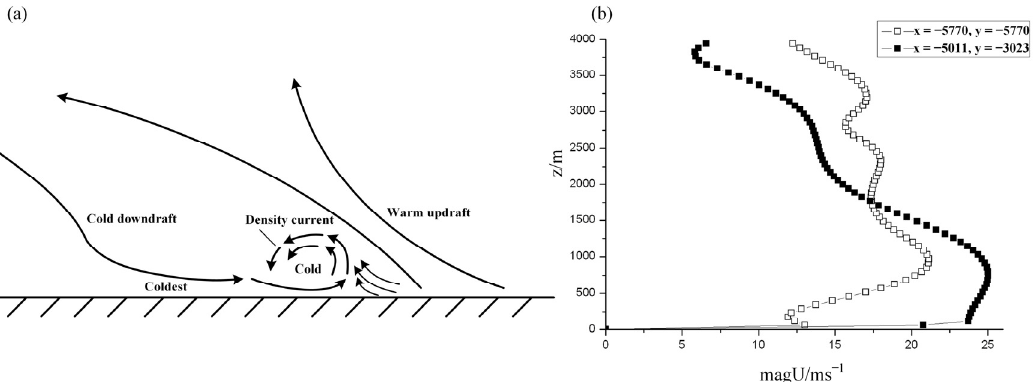
Figure 5. ( a ) Schematic diagram of the front lobe of a dust storm. A downdraft of cold air that spreads out along the ground and moves forward to form a density current, which could pick up loose dust and sand from the surface. The dense cold air pushes up warmer air, which it meets, thereby reinforcing the warm updraft (modified after Idso, S.B. 1976, Sci. Am. 235, 108–114). ( b ) The resultant wind velocity profiles at different altitude over two positions (x = − 5770 m, y = − 5770 m; and x = − 5011 m, y= − 3023 m) at t = 1500 s in the RANS simulation of LSS.